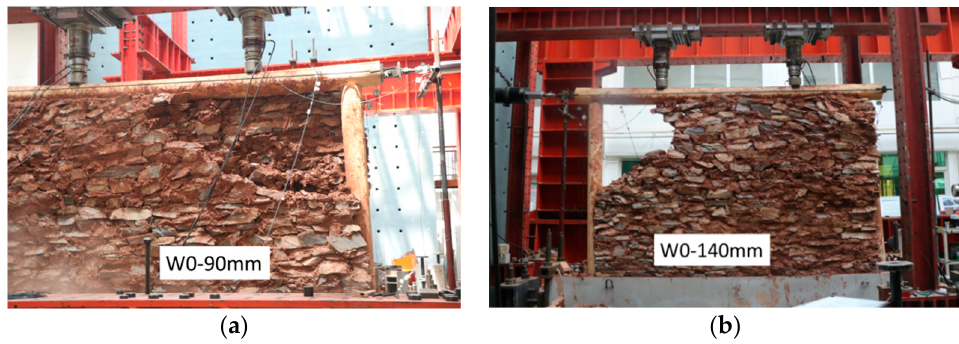
Figure 20. Displacement loading for specimen W0: ( a ) 90 mm and ( b ) 140 mm.